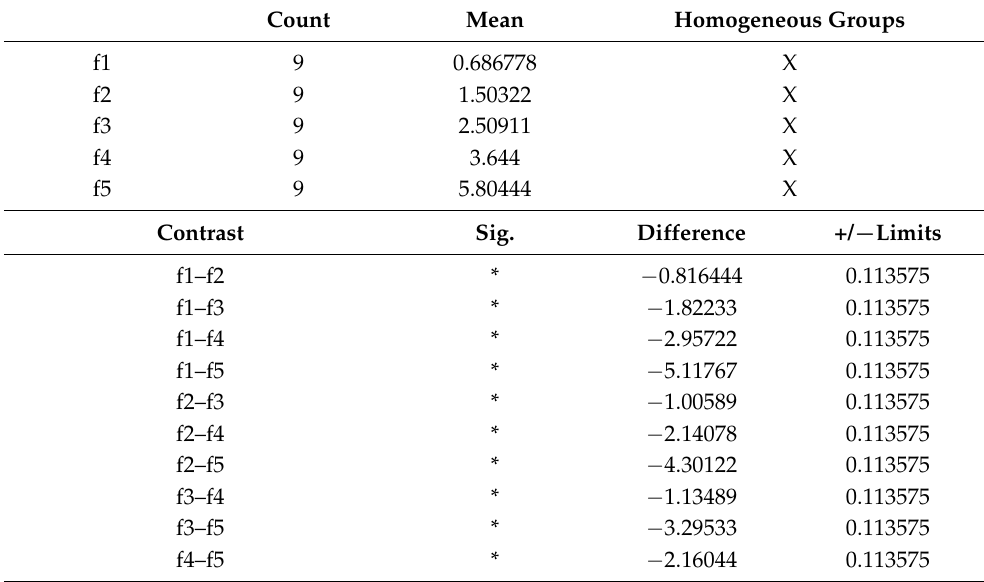
Table 7. Multiple range tests. Method: 95.0 percent LSD.